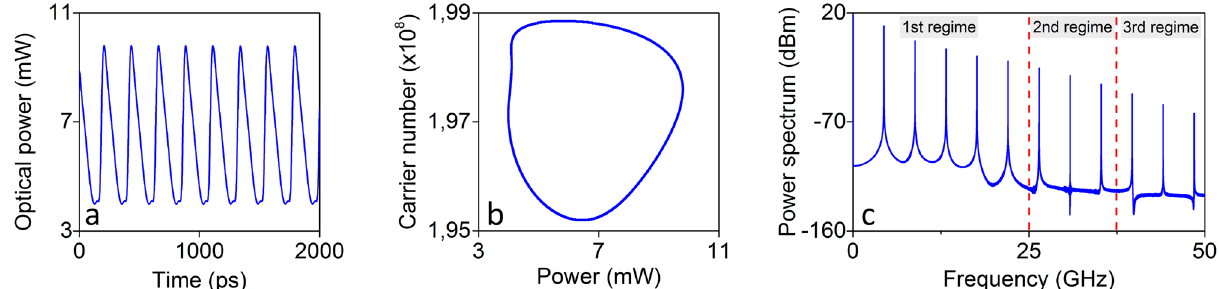
Figure 4. Repetitive temporal pattern emission ( a ) from a SL-OF system under a limit cycle dynamical operation ( b ) that originates from multiple equidistant microwave frequency tones ( c ). The operating